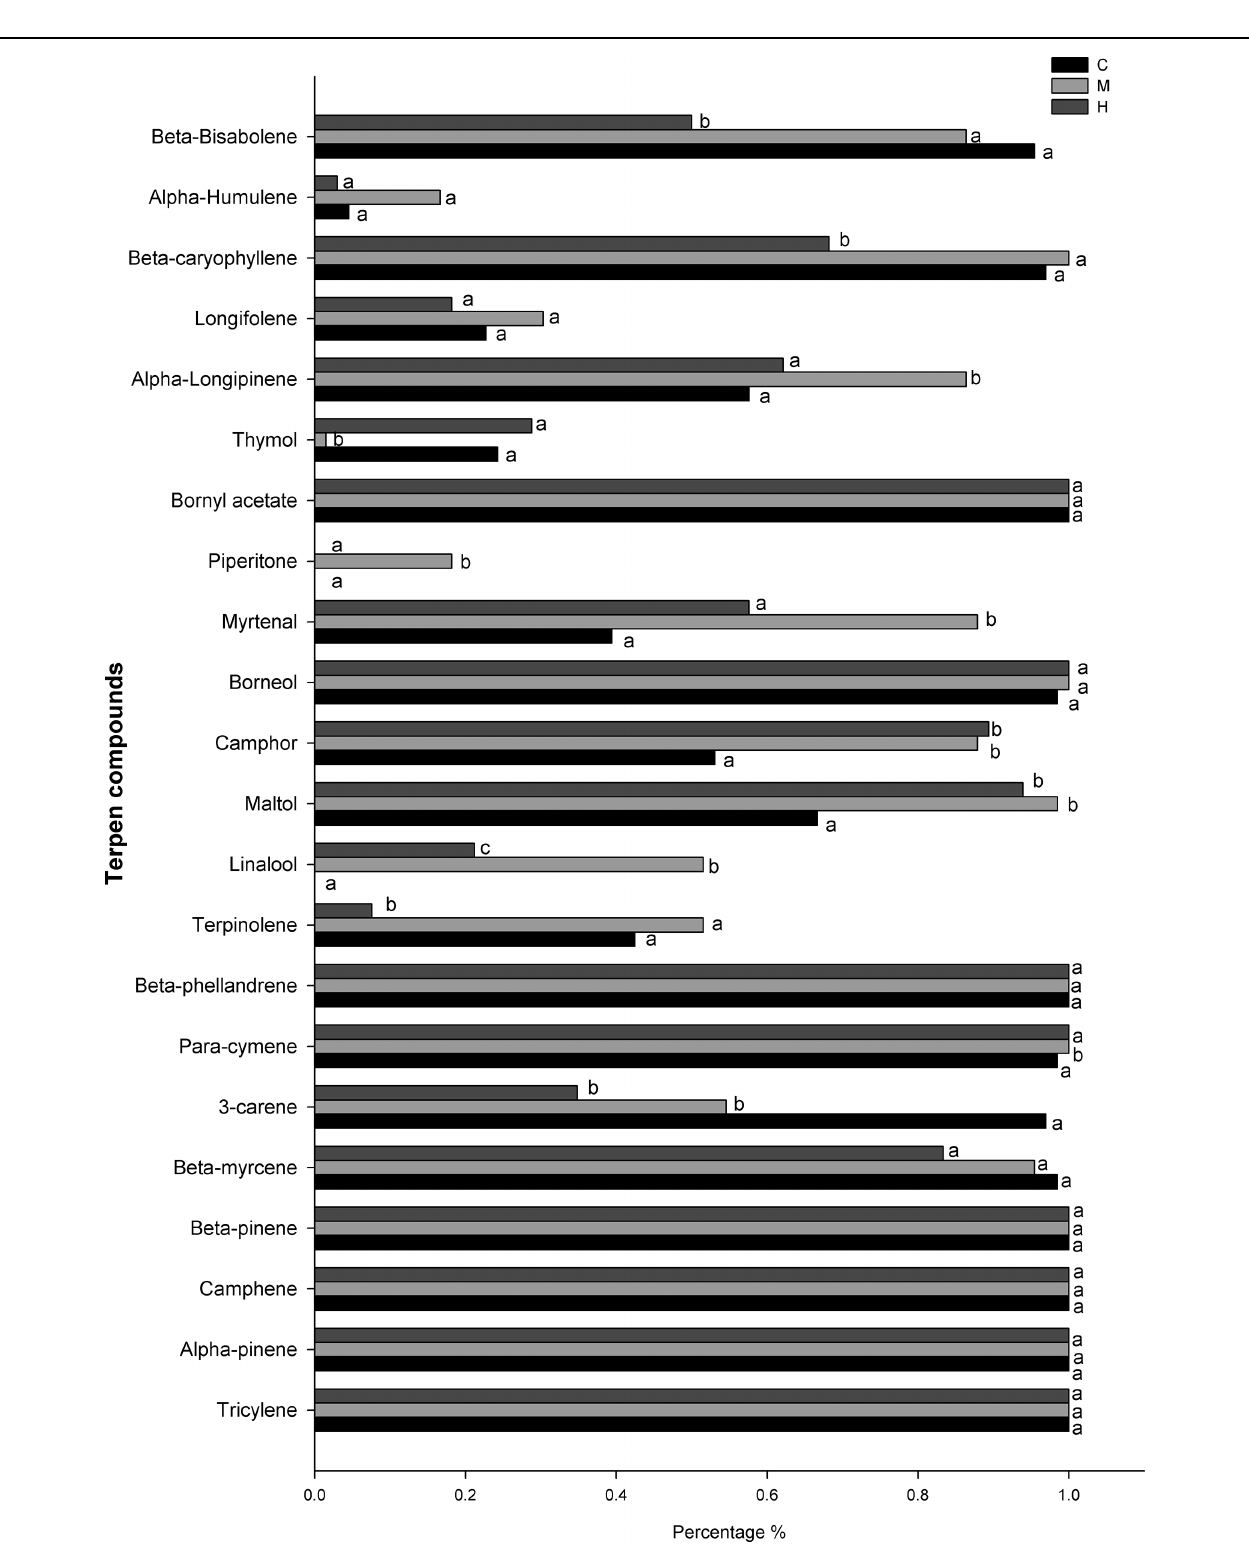
FIGURE 6 | Percentage of occurrence (presence) of defense compounds in the needle among all sampling dates for the different defoliation classes (C, control trees; M and H are moderately and heavily defoliated trees). Different letters (a, b, c) indicate a significant difference ( p < 0.05) between defoliation